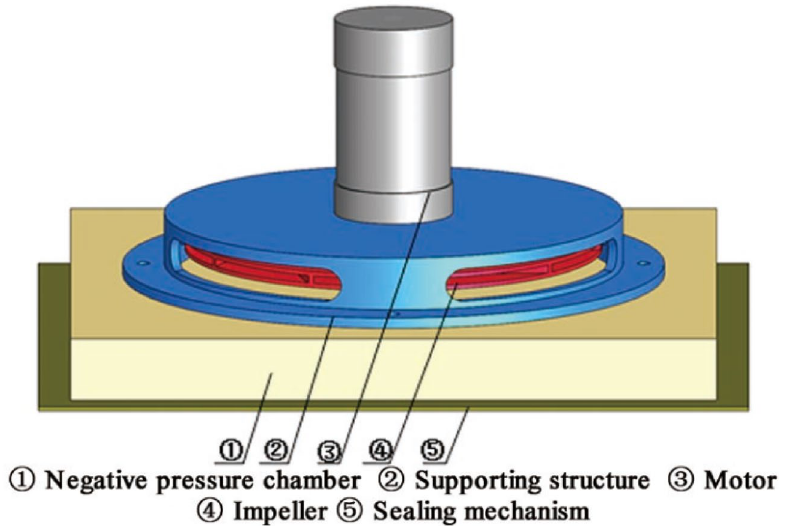
Figure 1. Composition of negative pressure system of wall-climbing robot.